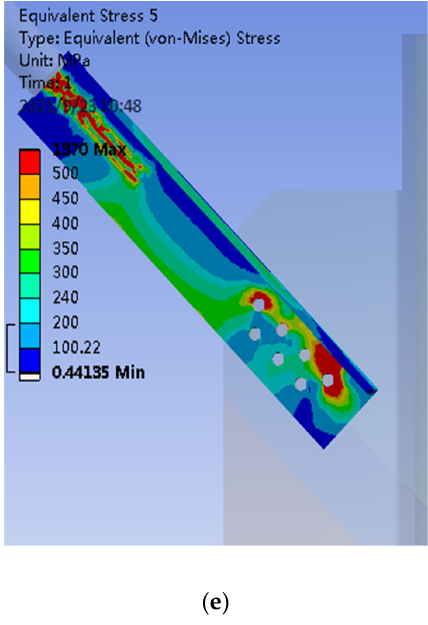
Figure 14. ( a ) Overall stress distribution of PSLSPJ; ( b ) stress distribution of the first path in the weld direction; ( c ) stress distribution of the second path in the weld direction; ( d ) stress distribution of connecting bolt of PSLSPJ; ( e ) stress distribution of angle steel of PSLSPJ.